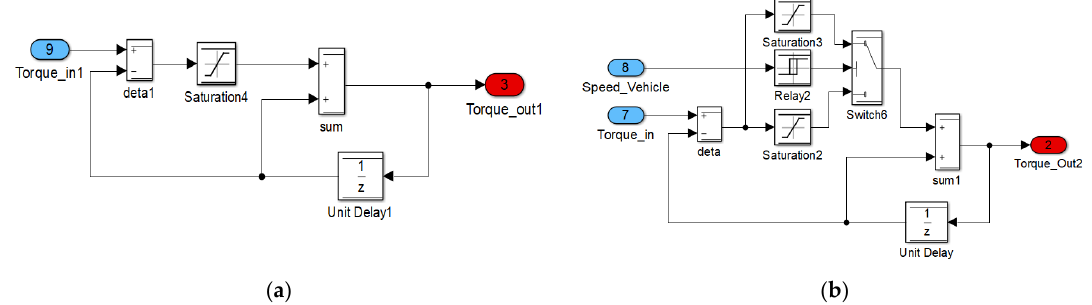
Figure 4. Schematic diagram of the torque increment adjustment method: ( a ) single rate; ( b ) multi-rate.